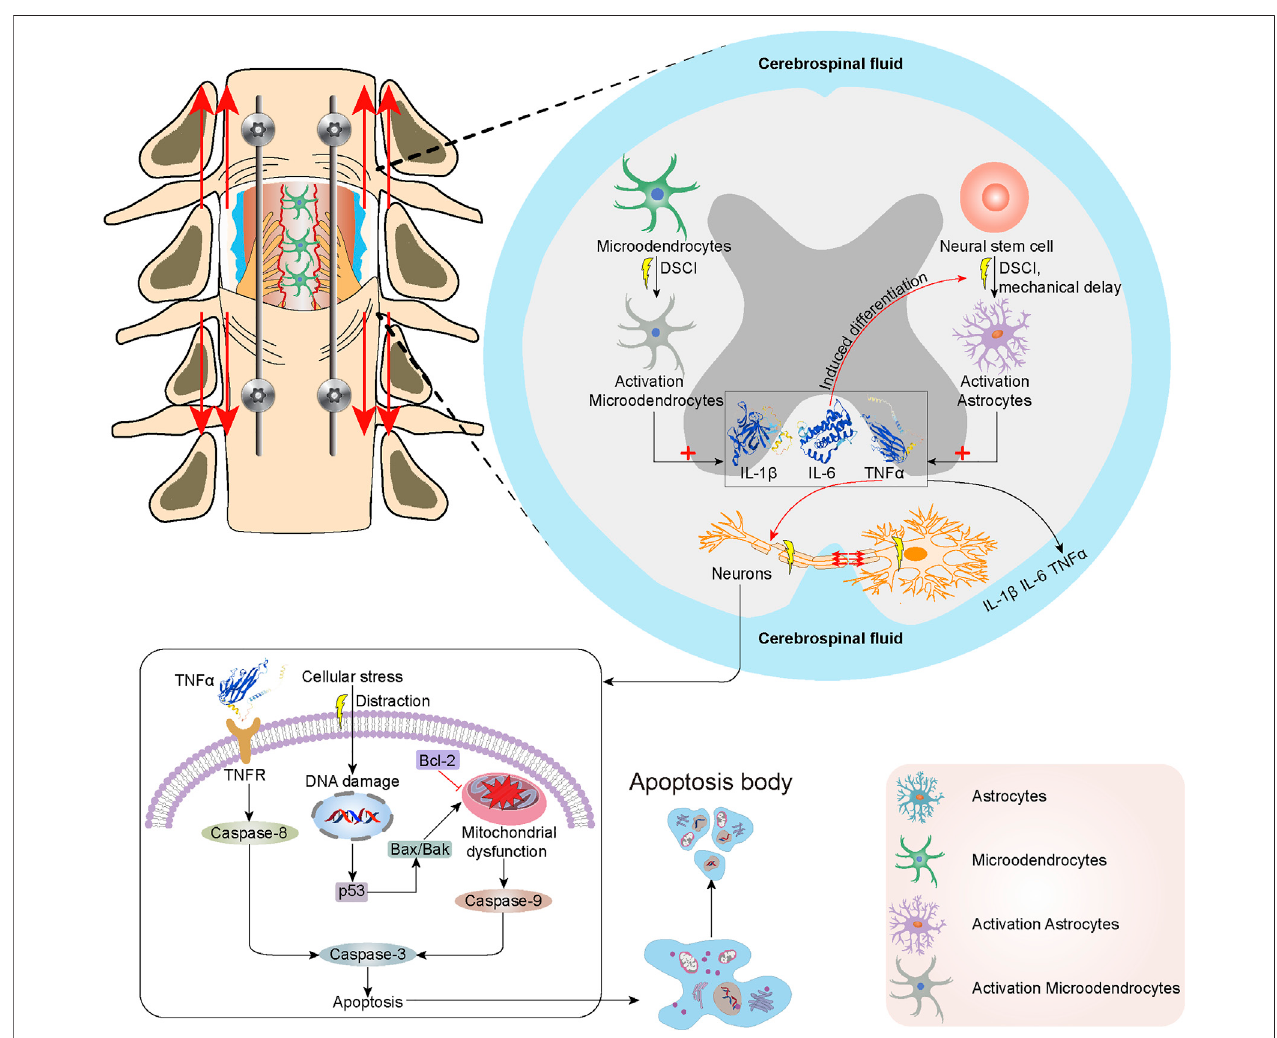
FIGURE 8 | The mechanisms of neuroin fl ammation and cell apoptosis in the spinal cord following DSCI. DSCI induced acute activation of microglia, followed by delayed astrocyte activation. DSCI induces the acute activation of resident microglia and upregulation of in fl ammatory cytokines, including TNF- α , IL-1 β , IL-6. Delayed astrocyteactivation increases theexpression ofGFAP, which results inthe production ofmultiple in fl ammatorycytokines. In extrinsic pathways,TNF- α binds to TNF-R1 on the surface of neurons to initiate apoptosis via Caspase-3 and Caspase-8. The intrinsic lethal stimuli induced by DSCI, such as the cellular stress, may cause DNAdamageandupregulatetheP53expression.P53inducesBax/Bakoligomerizationinthemitochondrialoutermembrane,whichcanpromotethereleaseofvarious intermembrane proteins. Bcl-2 suppresses Bax-induced apoptosis by forming a homodimer and heterodimer. Finally, Caspase-8, Caspase-9, Caspase-3 were activated to up-regulate their expression and initiate cell apoptosis of DSCI.